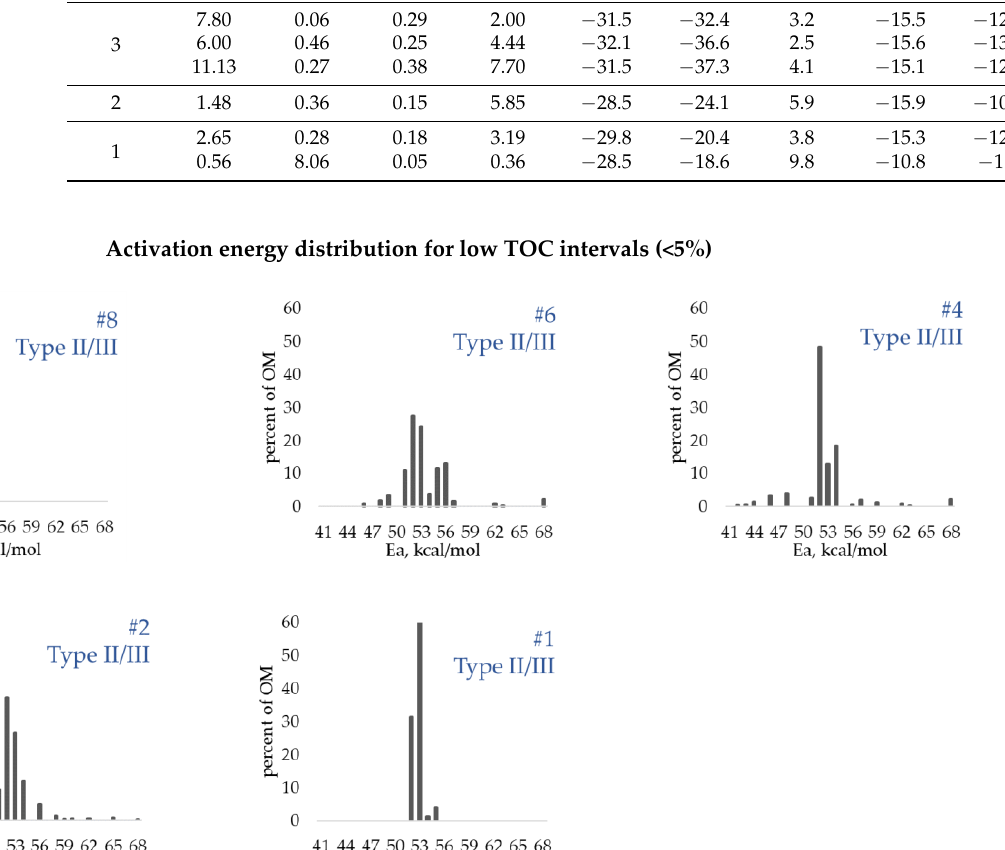
Figure A2. Representative bulk kinetic spectra (A = 1 × 10 14 s − 1 ) of kerogen decomposition for high TOC members #3, #5, and #7.